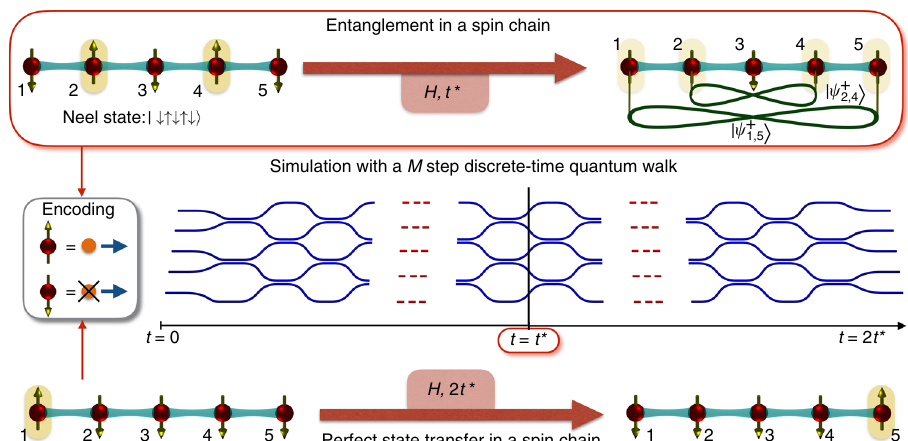
Fig. 1 Quantum simulation of spin chain dynamics and the entanglement growth therein in photonic platforms. Fermions simulated on the network map, via the Jordan – Wigner transformation, to spin excitations in a chain: occupied and unoccupied modes correspond respectively to spin up and spin down. The couplings of the effective spin chain Hamiltonian are so engineered as to generate, starting from a Néel state, at a time t * , a state with maximal entanglement between distant symmetric sites with respect to the centre of the chain. ψ þ i ; j This rainbow state exhibits a volume law entanglement in which the entanglement between the left and the right halves of the chain is ~ N /2. The time evolution is approximated through a set of discrete steps (a digital approach). If the dynamics was continued up to time 2 t * , it would implement an approximately perfect